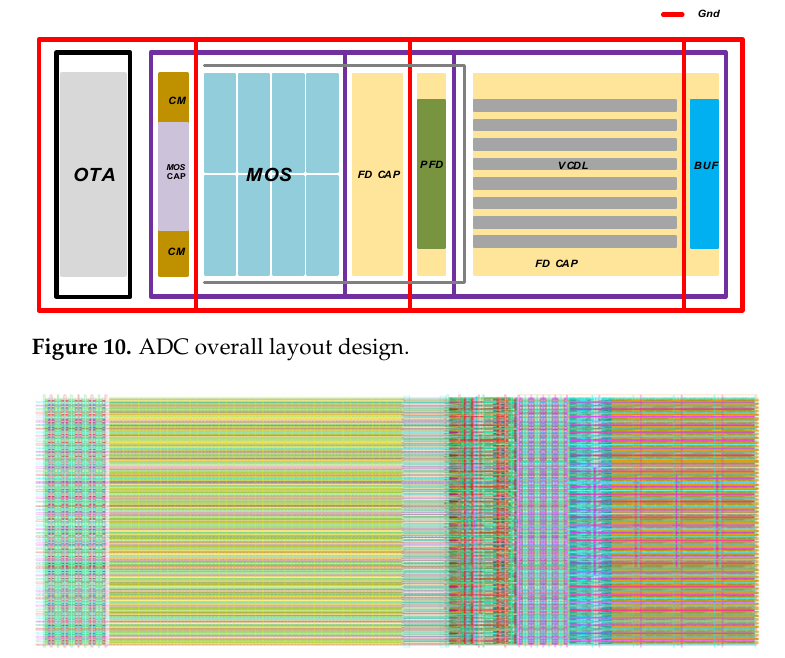
Figure 11. ADC overall layout.